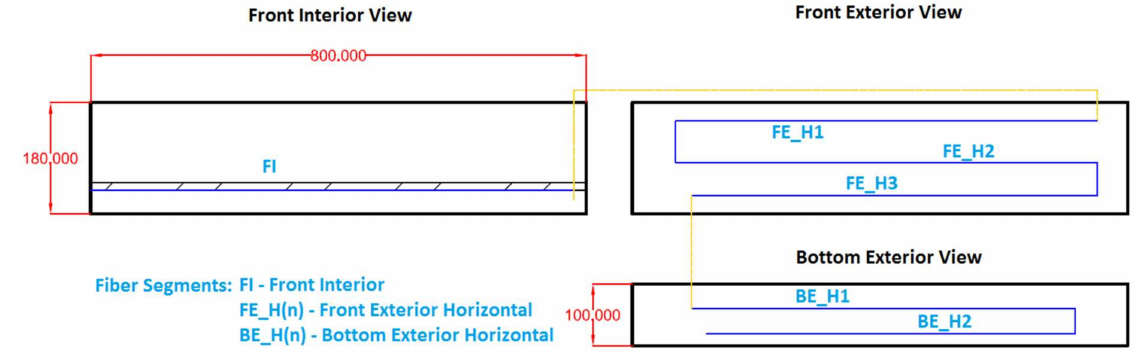
Figure 8. Definition scheme of DOFS deployed on each beam—all dimensions